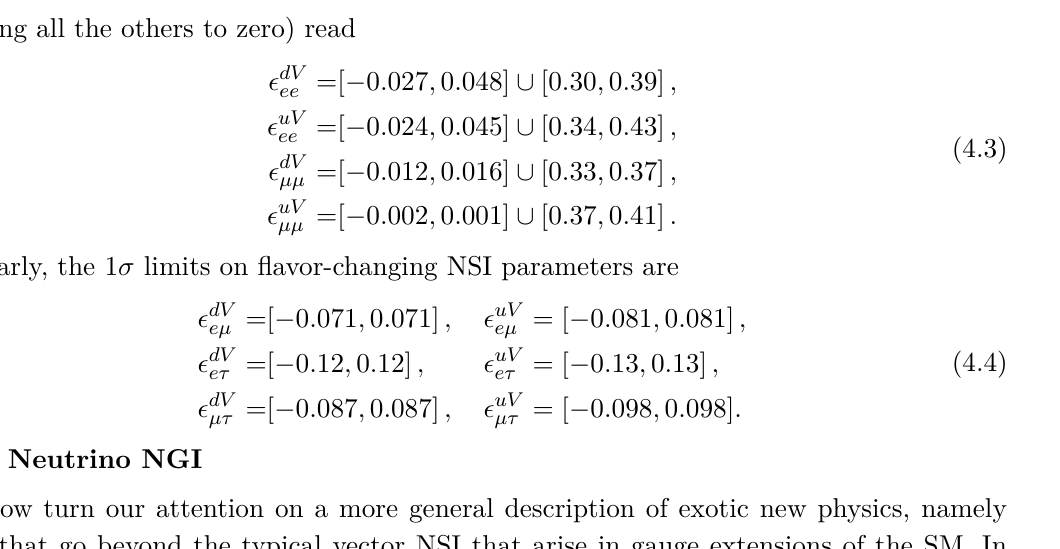
) plane while the lower , (cid:15) dV ee eτ ) . The analysis of CsI data includes only CE ν NS , (cid:15) dV µµ µτ